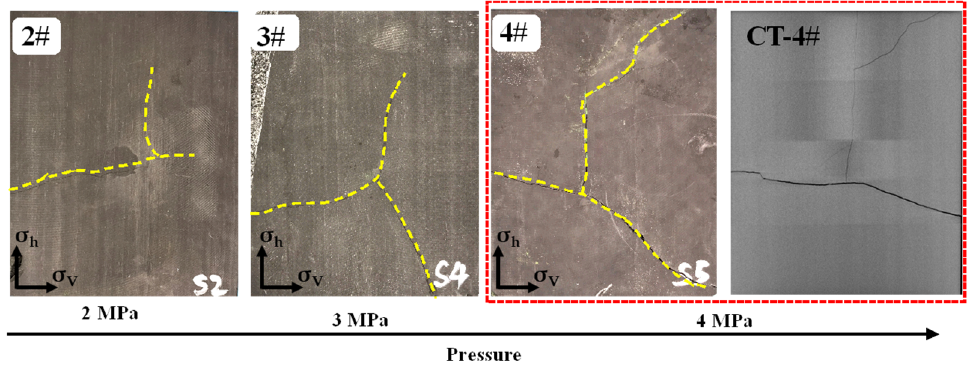
Figure 6. The fracture morphologies of specimens 2#, 3#, and 4#, which are similar, and all